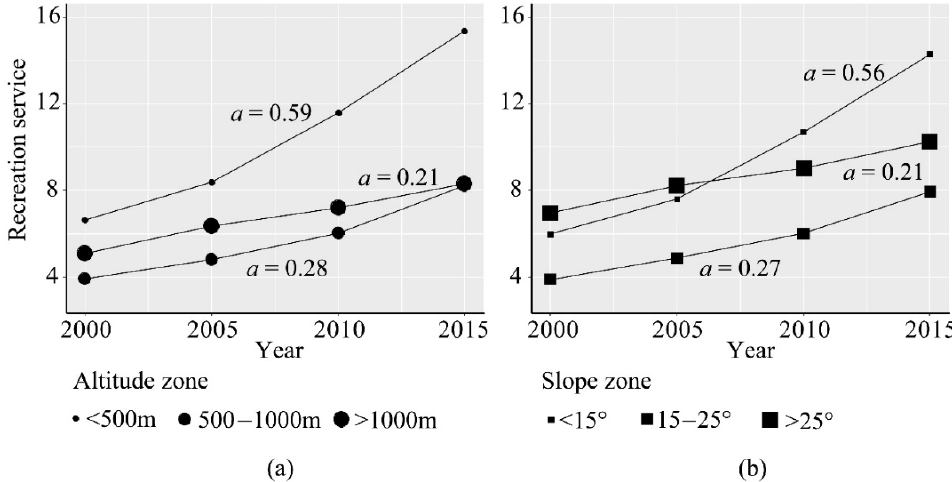
Figure 3. Temporal variations of the recreation-service proxy in different zones of altitude ( a ) and slope ( b ) in the TGRA. Note: We used a least square linear regression model to fit the recreation proxy. The changing trend is described by the modeled slope, which is a in the figure.